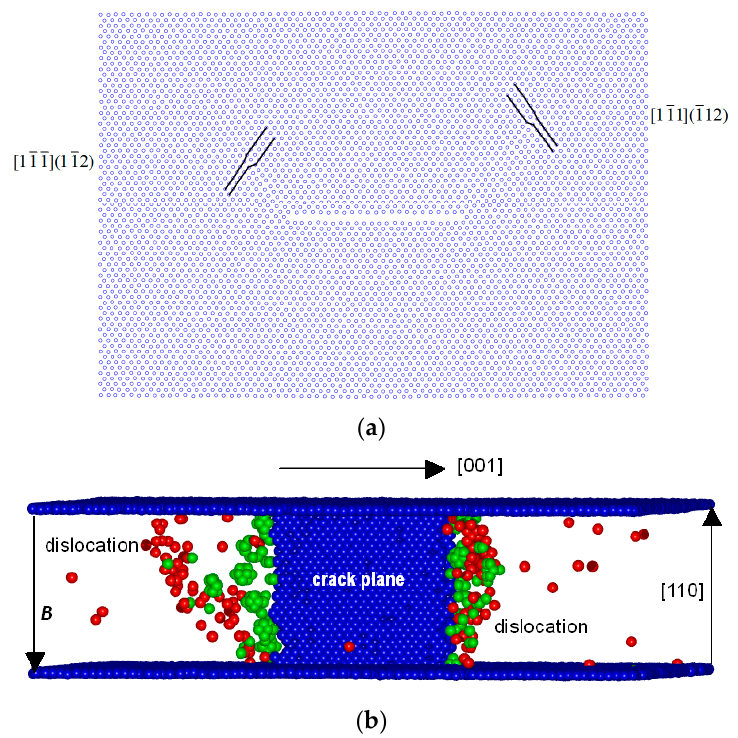
Figure 10. Temperature 600 K—the final < 111 > {112} dislocation emission at α = 0.8: ( a ) 2D visualization of two dislocations in (110) middle layer at time step 6000 (K A (t) = 0.573 MPa · m 1 / 2 ); ( b ) the corresponding 3D visualization at the same time step 6000.